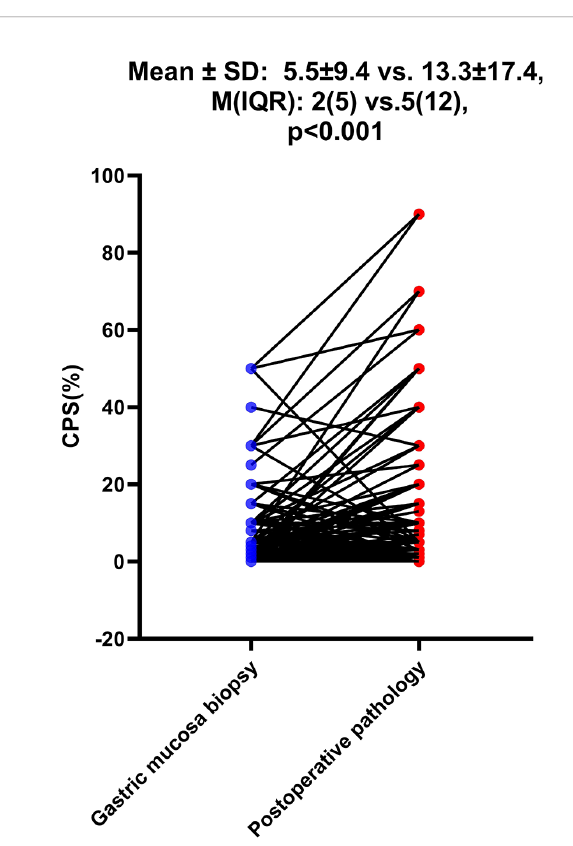
FIGURE 4 | The difference of CPS between primary gastric cancer and metastatic sites. The Student ’ s paired t-test was used to compare